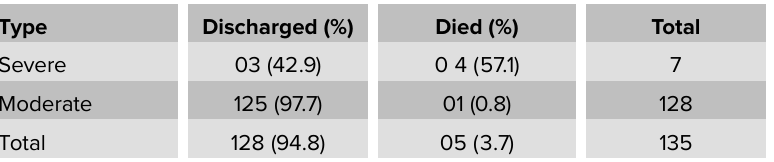
TABLE 3: Severity phenotype and outcome in the control